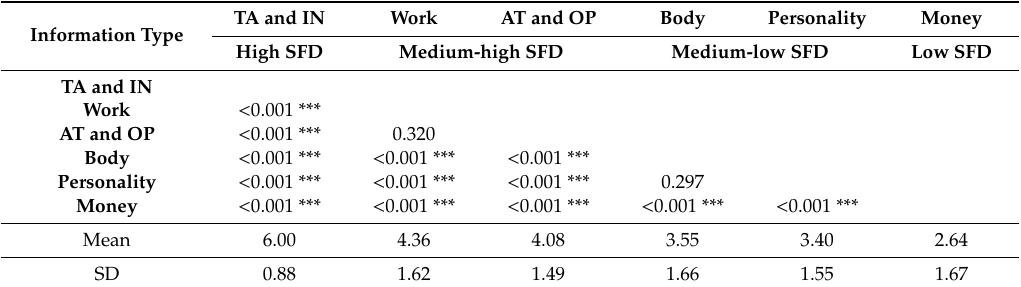
Table 3. Summary of post-hoc tests for self-disclosure in Experiment 2. SFD: self-disclosure, TA and IN: tastes and interests, AT and OP: attitudes and